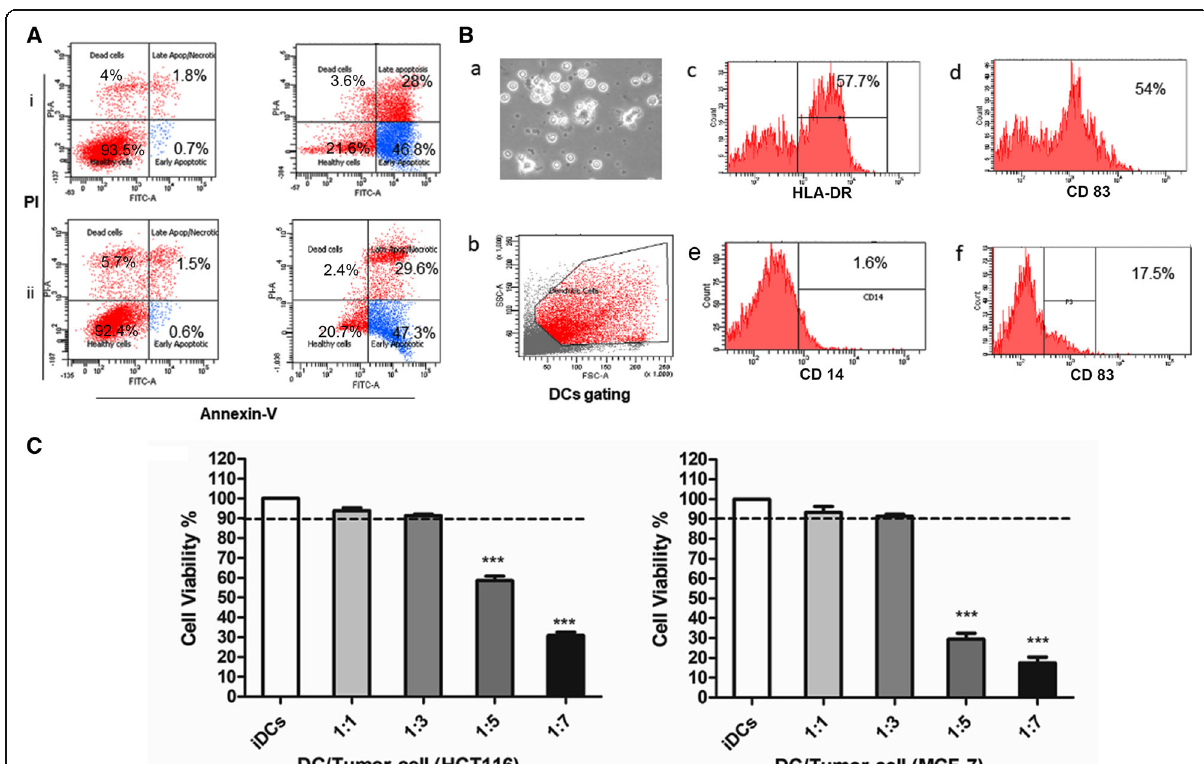
Fig. 2 Generation of tumor lysate and monocyte-derived dendritic cells. a Flow cytometric analysis of the apoptotic effect of 80% ethanol extract of Phyllanthus amarus on (i) HCT-116 and (ii) MCF-7. b Characterization of the generated immature monocyte-derived DCs ex vivo at day 6 (a) microscopically, (b) representative gating strategy, and (c-f) flow cytometric analysis of HLA-DR + , CD 83 + , CD 14 − and CD 86 + expression by iDCs. c The cell viability assay of DCs treated with PA generated tumor lysate (HCT 116 and MCF-7 TLY) by trypan blue exclusion method after 48 h. The data are representative of three experiments comprising three different healthy donors and analyzed by one-way ANOVA followed by Dunnett ’ s test. *** P < 0.001. Mean ± SEM. are shown. DCs, Dendritic cells; PA, Phyllanthus amarus ; Ann V, Annexin V; PI, Propidium